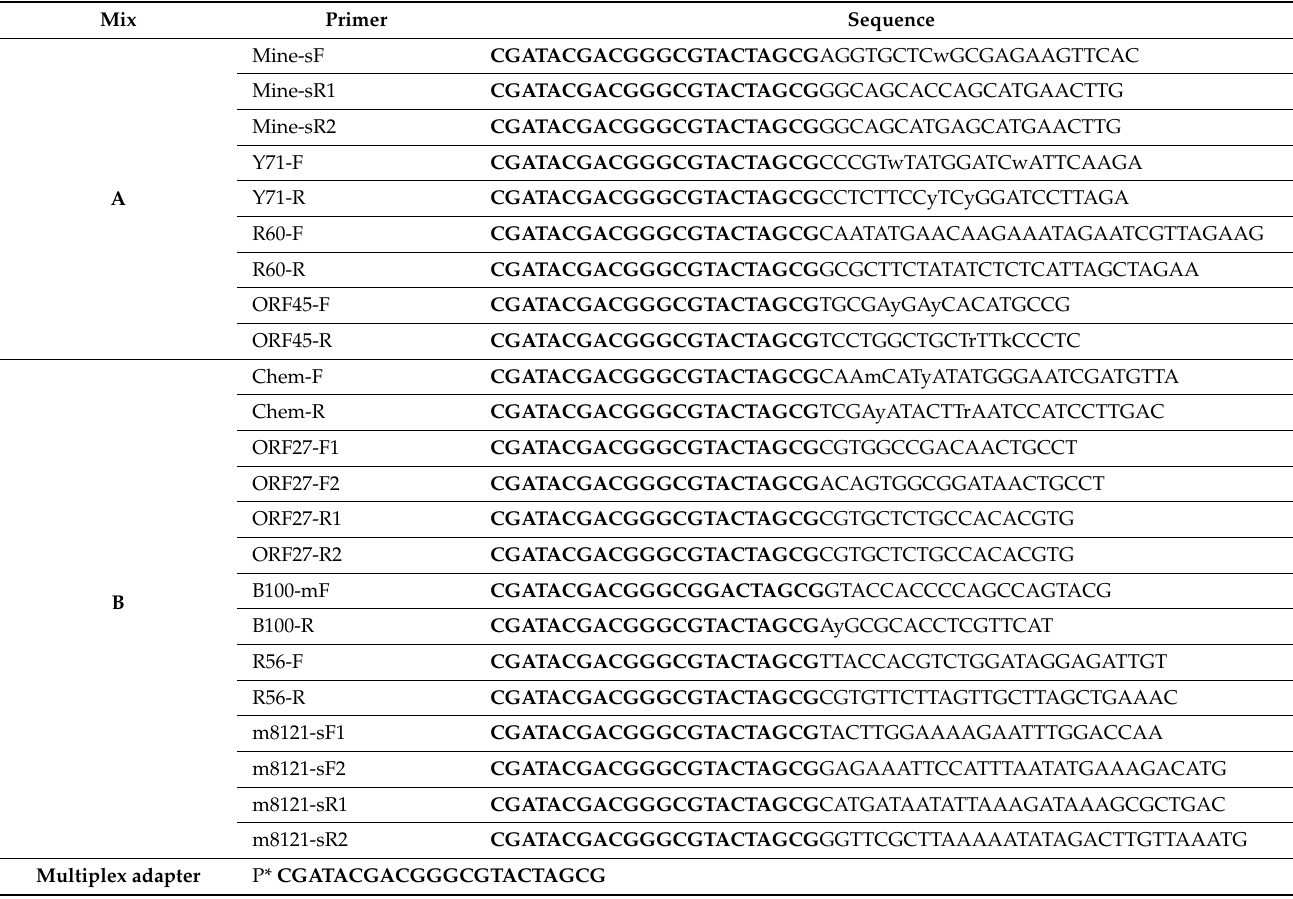
Table 2. Primers for the diagnostic regions in the RANS